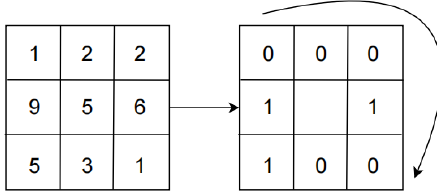
Figure 7. Principle of LBP feature extraction.